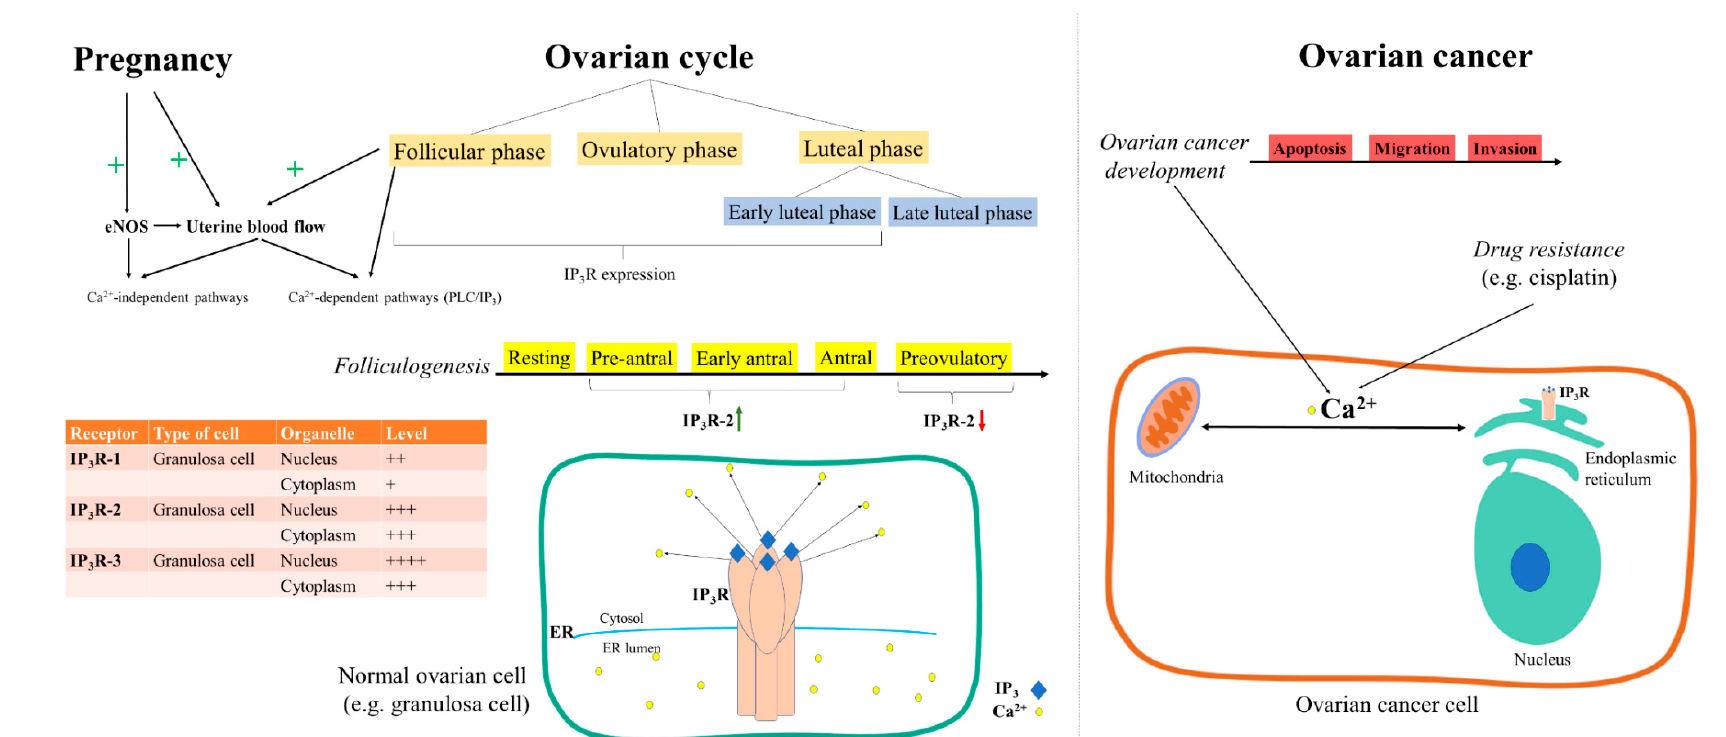
Figure 2. IP 3 R-mediated Ca 2+ signaling in ovarian physiology and cancer. During pregnancy and the follicular phase of the ovarian cycle, uterine blood flow is increased, and this event is related to Ca 2+ -dependent (PLC/IP 3 ) or -independent pathways [106]. IP 3 Rs are expressed in the follicular phase and the early luteal phase, but not in the corpus luteum in the mid-luteal phase of the ovarian cycle [109]. Granulosa cells express all IP 3 R subtypes, with distinct levels of expression (+, ++, +++, ++++) in nucleus and cytoplasm [81]. During folliculogenesis, IP 3 R-2 in granulosa cells are upregulated ( ↑ ) in the pre-antral and mid-antral phases, and downregulated ( ↓ ) in the preovulatory phase [109]. In ovarian cancer, the alteration of homeostasis in the ER–mitochondrial IP 3 R-mediated Ca 2+ transfer is essential, contributing to ovarian cancer progression (apoptosis, migration, and invasion) and development of drug resistance [110–114].